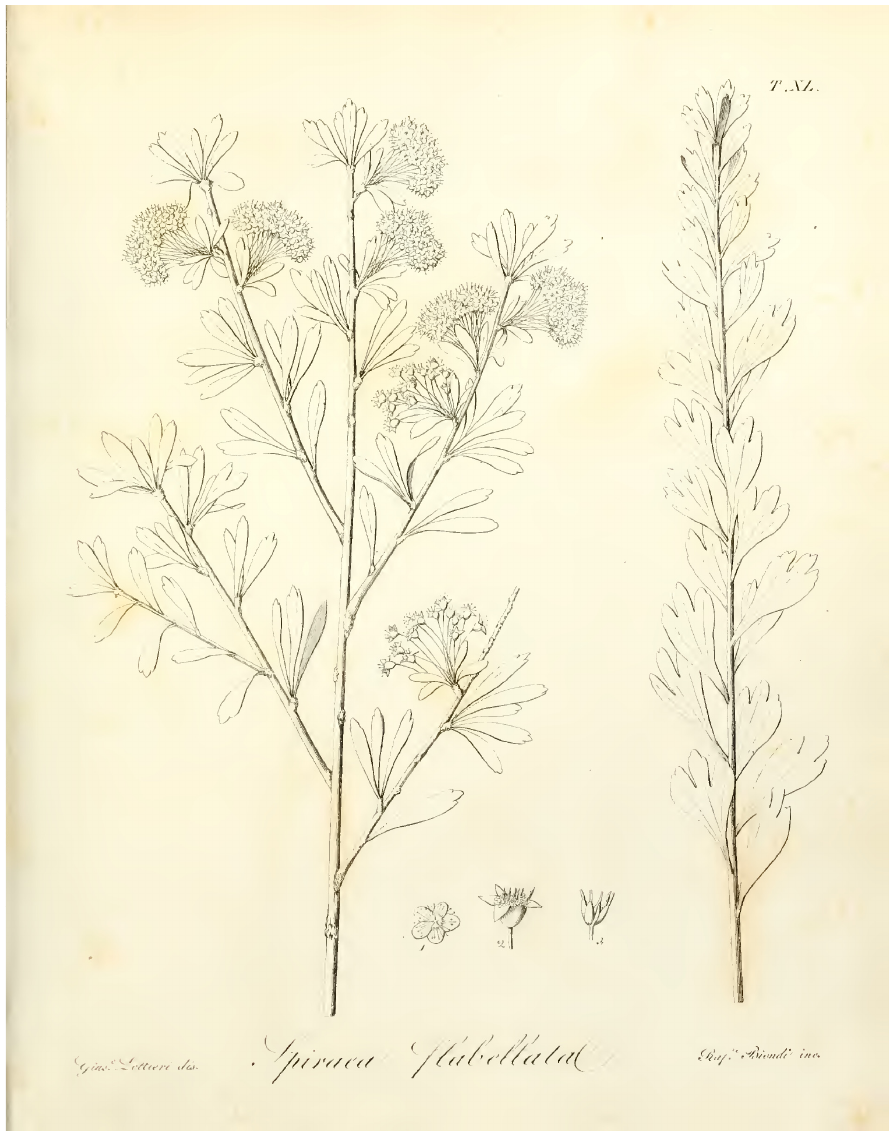
Figure 2. Illustration of S. flabellata cited in the protologue by Gussone as “t.